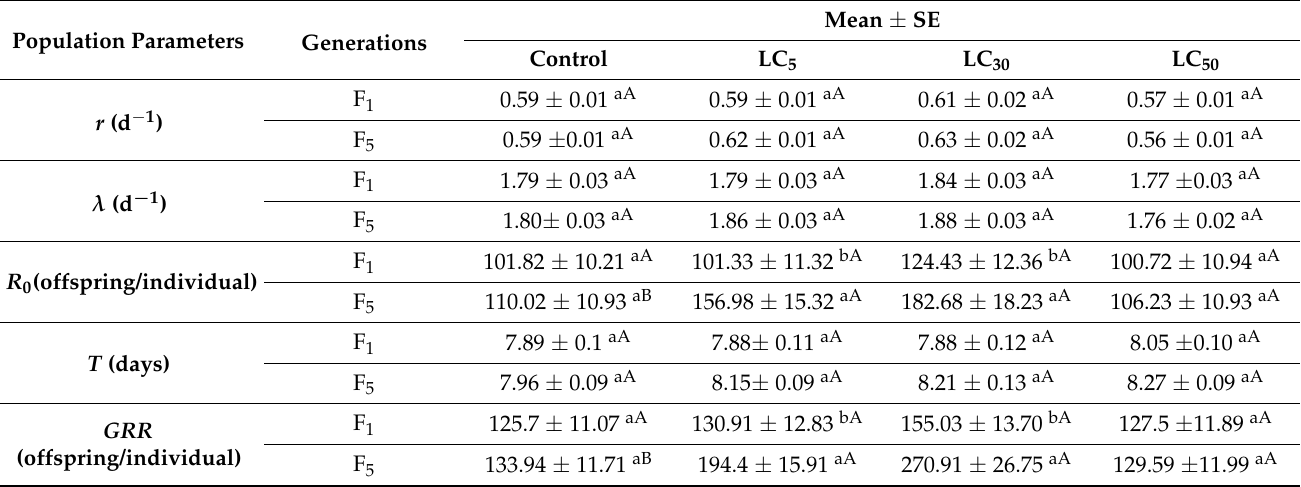
Table 3. Multigenerational effects of Imidacloprid on the population parameters of F 1 and F 5 generations of T . chilonis